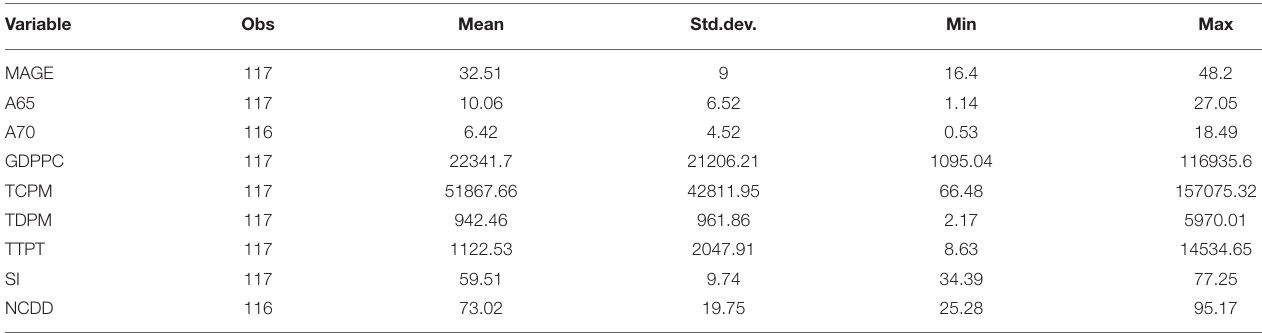
TABLE 3 | Descriptive